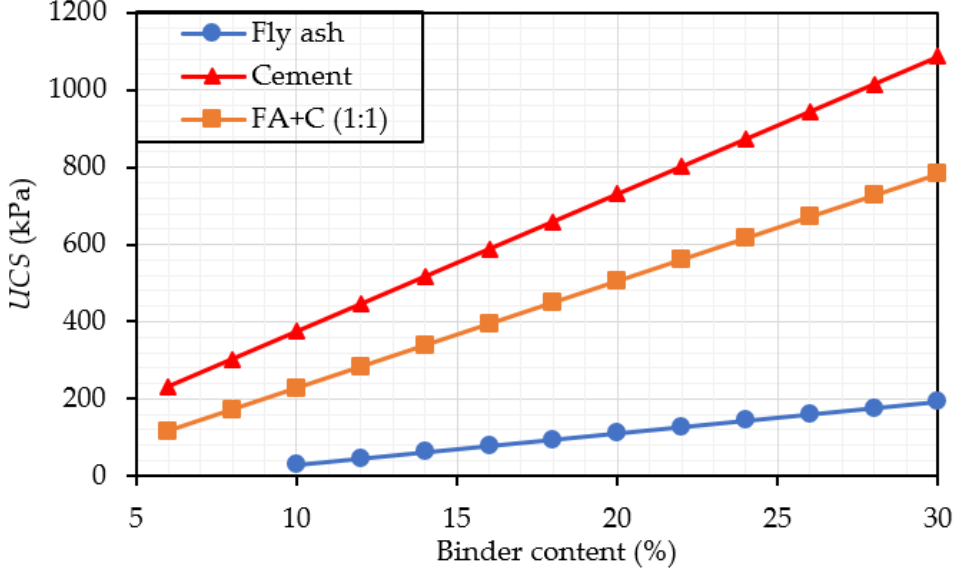
Figure 3. Effect of binder type and binder content.